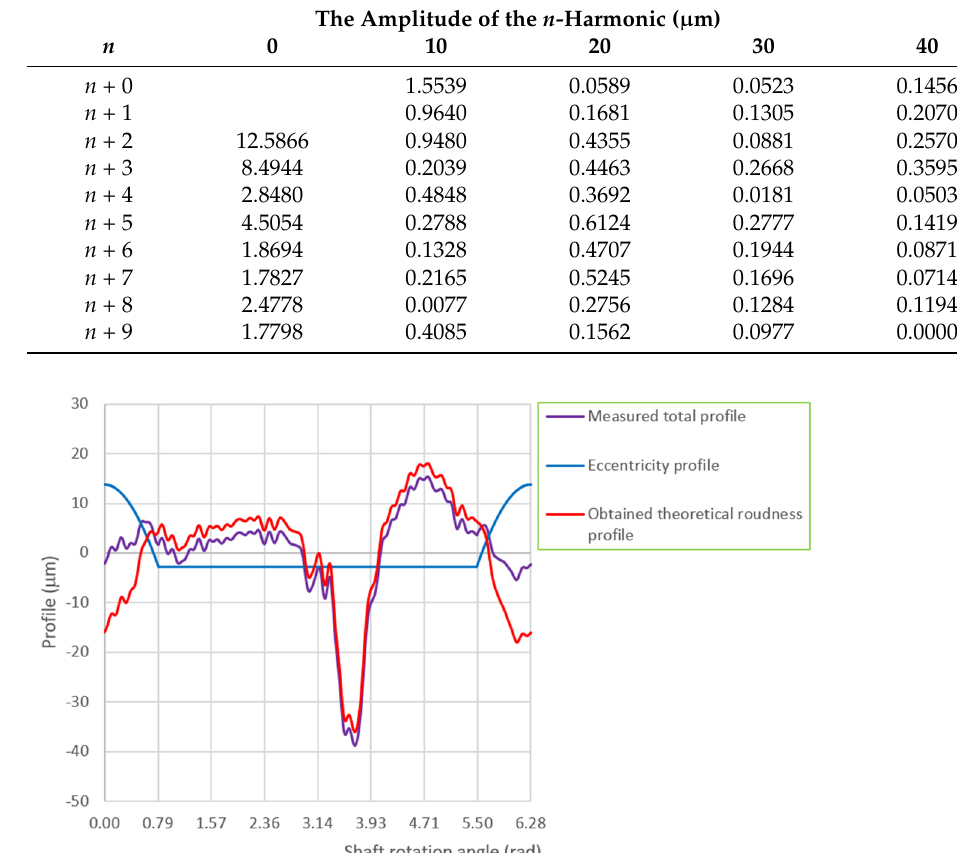
Figure 15. Summary of profiles for journal No. 4.